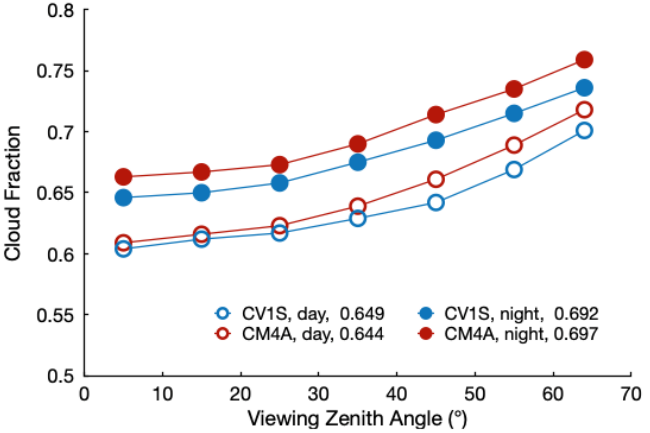
Figure 4. Mean 2013 global cloud fractions as a function of VZA for Aqua CM4 and CV1S.